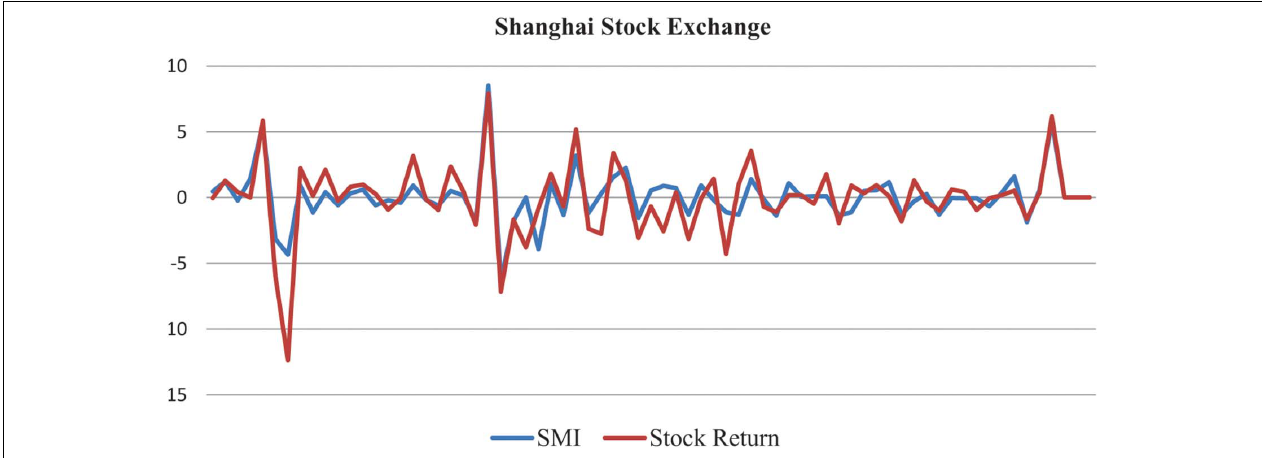
FIGURE 2 | Relationship between Shanghai stock returns and created Sentiment Index.